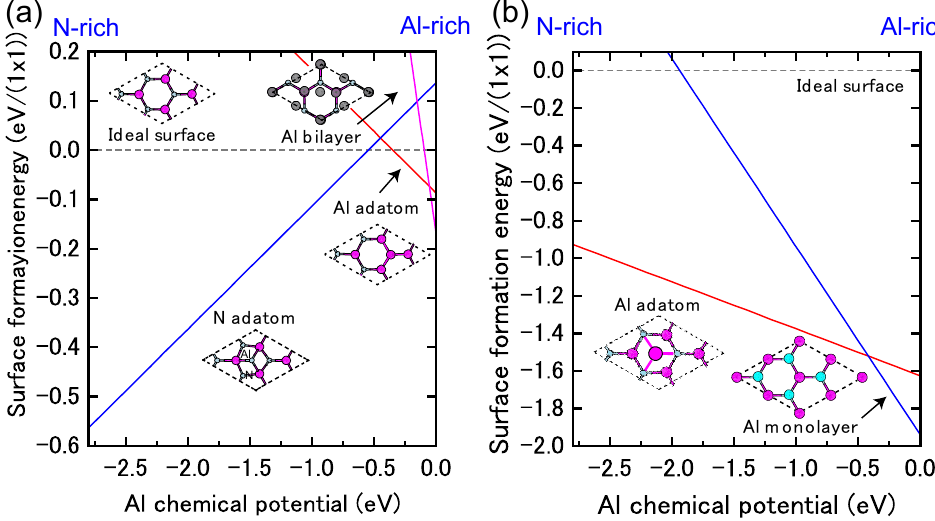
Figure 23. Calculated surface formation energies for polar AlN surfaces with ( a ) (0001) _ and ( b ) (0001 ) orientations as a function of Al chemical potential. Schematics of the surface structures under consideration are also